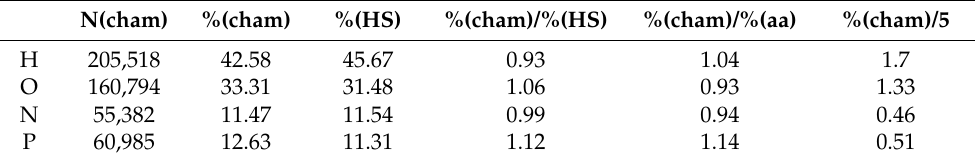
Table 6. Chameleon propensities of hydrophobic (H), polar (P), positive (+), and negative (-) residues. N(cham) %(cham) %(HS) %(cham)/%(HS)